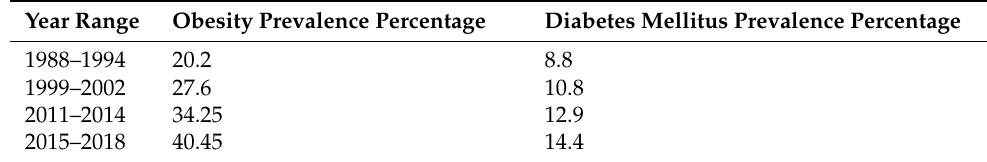
Table 1. Rising incidence of obesity and diabetes mellitus.